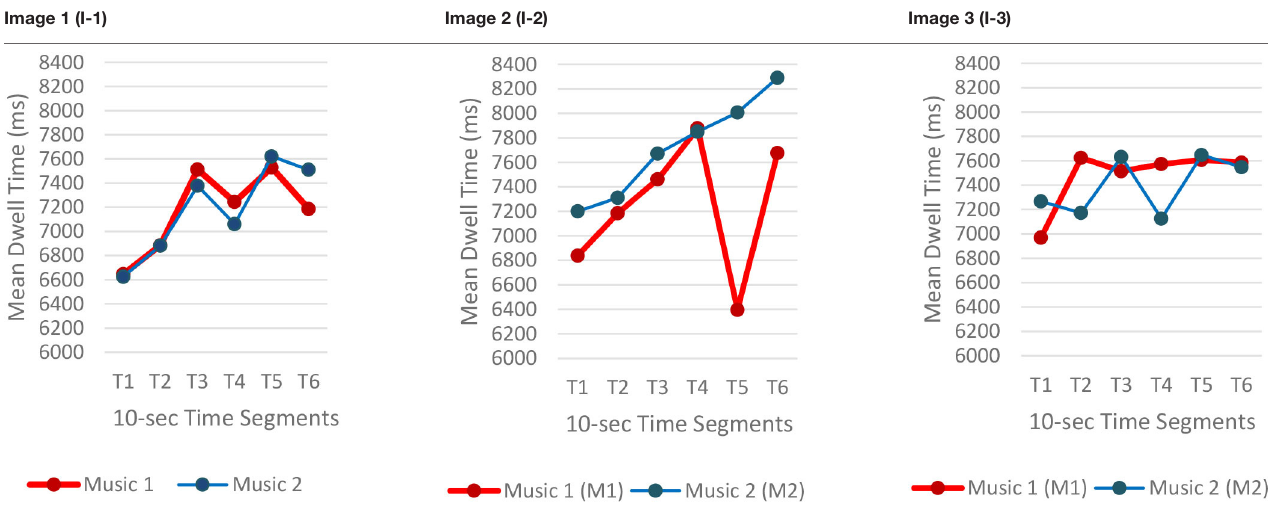
TABLE 3 | Mean dwell time by time